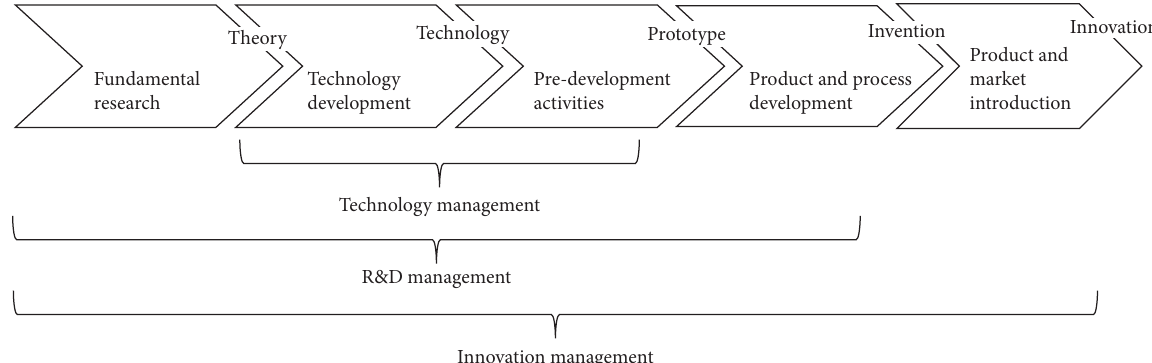
Figure 1: Te innovation management spectrum